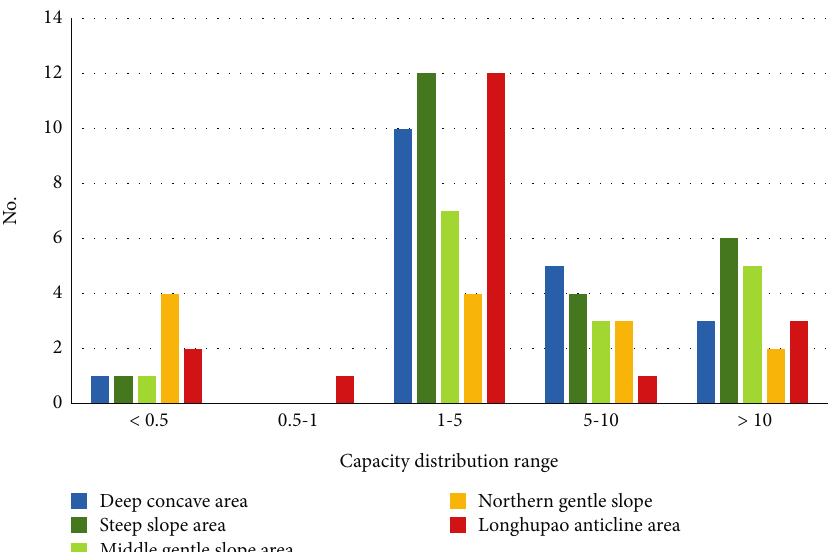
Figure 1: Productivity distribution of grapevine oil layer.